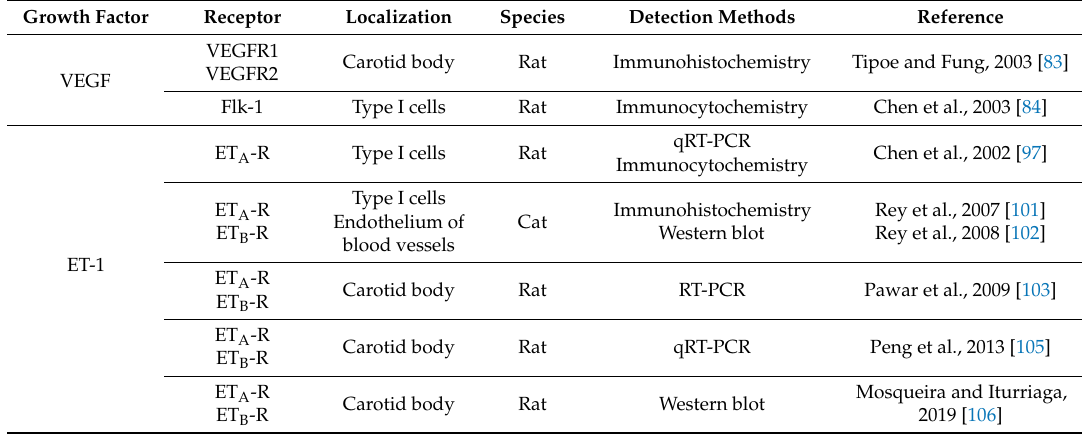
Table 12. Vascular growth factor and endothelin receptors. Expression of VEGFR1, VEGFR2, Flk-1, ET A -R and ET B -R in the carotid